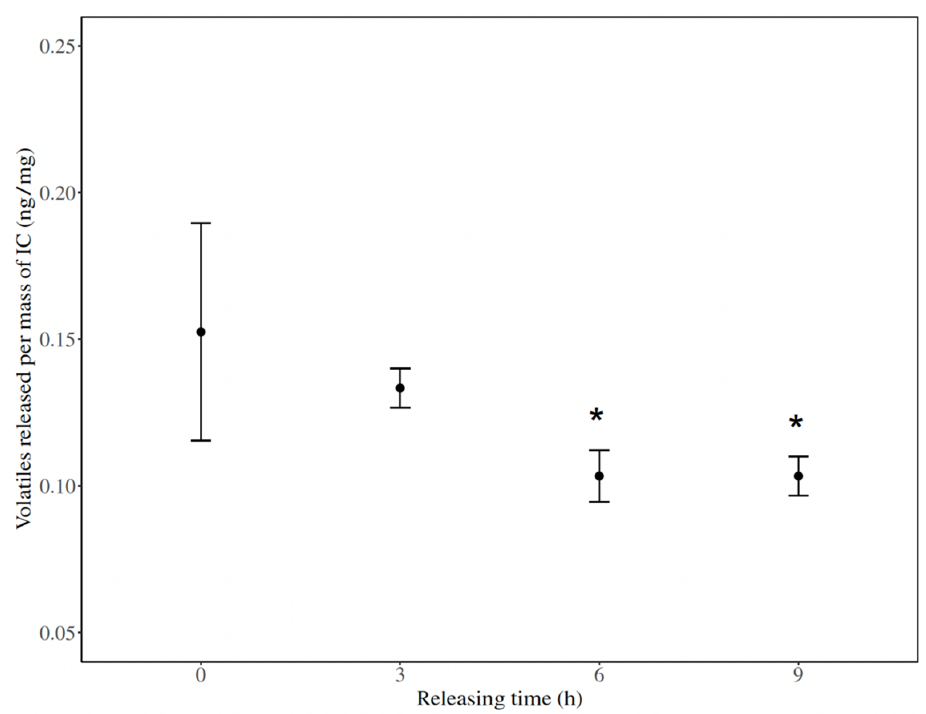
Figure 2. Release of catnip oil volatiles from [catnip: β -CD] inclusion complex (IC) over time. Volatiles measured by SPME/GC-MS ( n = 3, * p < 0.05). Error bars represent the standard error for each time measured. Quantification of volatiles released was performed by using the standard curves of catnip oil in hexane. Asterisks indicate data points that are significantly different from time